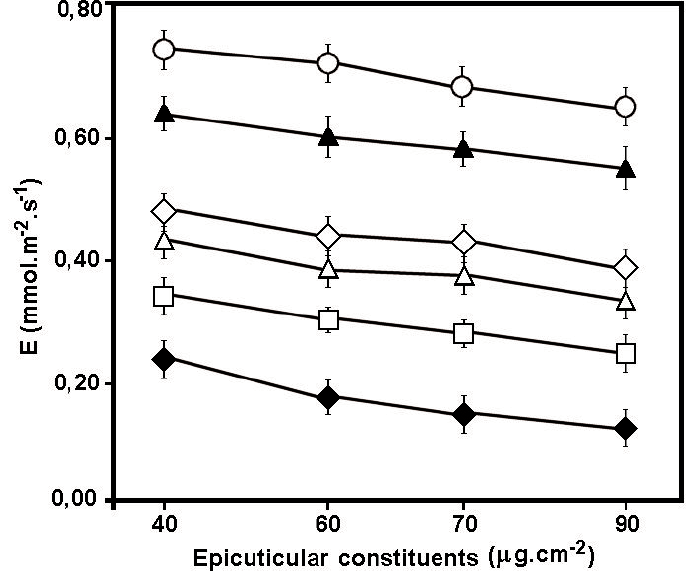
Fig. 3 – Evaporation rates ( E ) inWhatman paper discs impregnated with constituents separated from foliar epicuticular waxes of species from caatinga and cerrado. Empty symbols correspond to triterpenoids. ( (cid:3) ) ursolic acid, ( (cid:3) ) hentriacontan-16-one, ( ♦ ) lupeol, ( (cid:6) ) lupeol + β -amyrin, ( (cid:1) ) epifriedelinol, ( (cid:4) ) n -alkanes. Values corre- spond to means ± sd (n = 30), obtained at 25 ◦ C and 65% relative